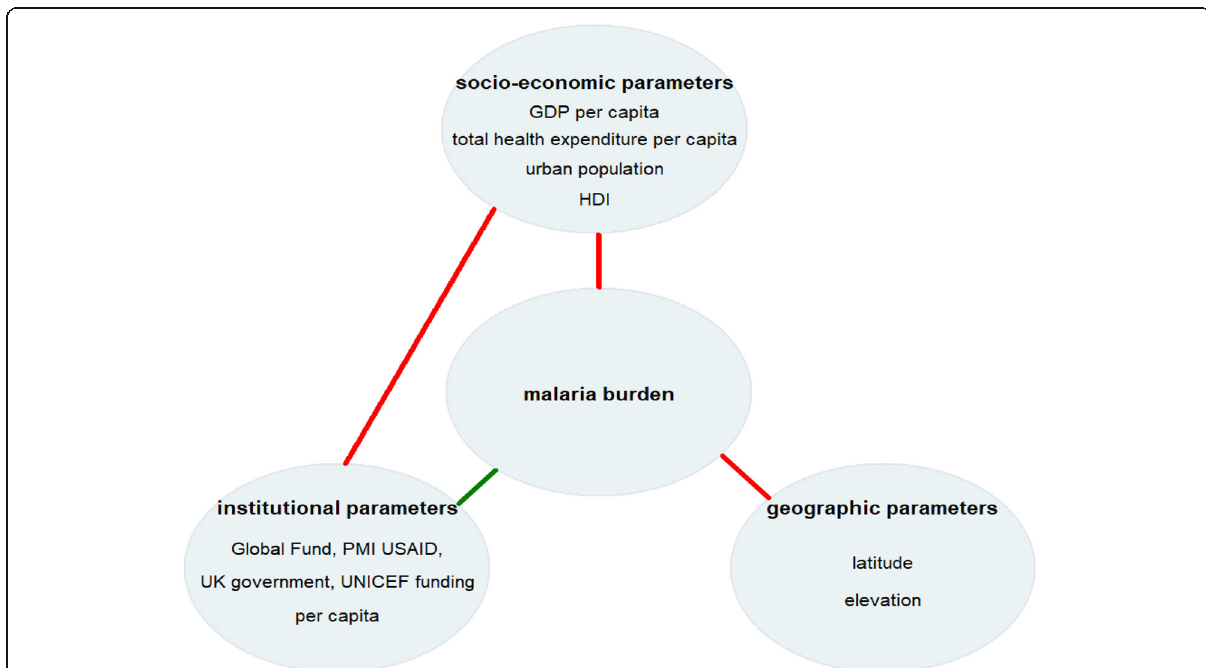
Fig. 1 Conceptual framework of malaria burden. * framework categories (socio-economic, institutional and environmental) with corresponding parameters. a green line indicates a positive correlation, a red line indicates a negative correlation of parameters with malaria burden. GDP: gross domestic product; HDI: human development index; PMI: United States President ’ s Malaria Initiative; UK: United Kingdom of Great Britain and Northern Ireland; UNICEF: United Nations Children ’ s Fund; USAID: United States Agency for International